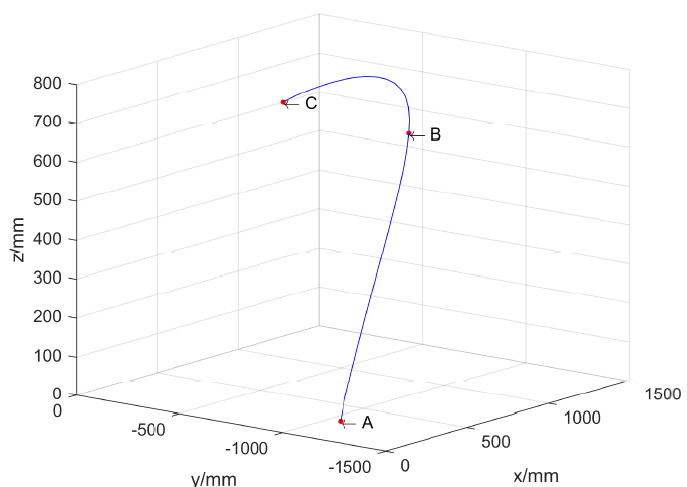
Figure 8. The track curve of loading.